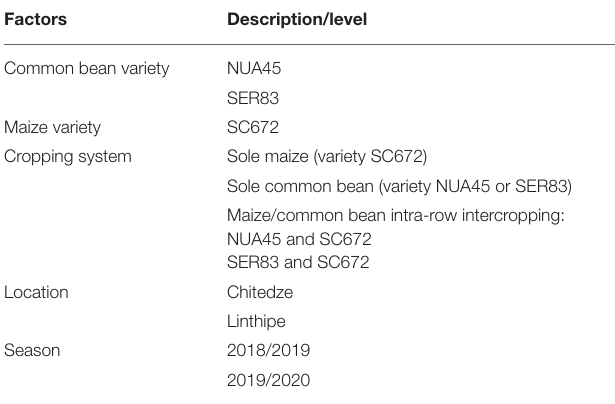
TABLE 3 | The factors and their levels/descriptions used in the